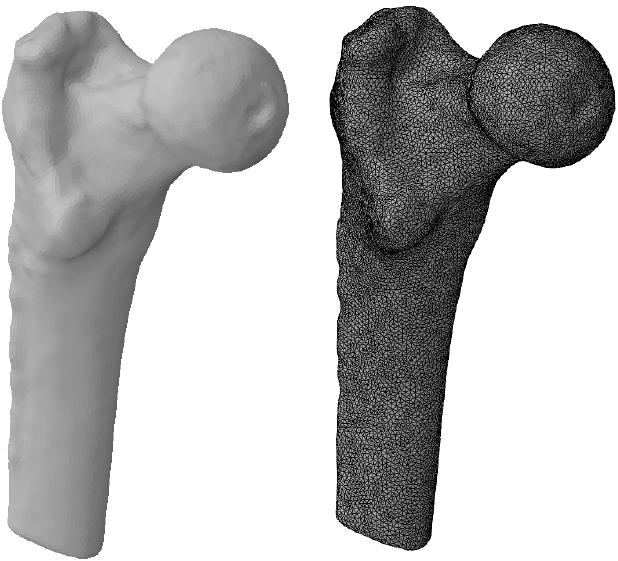
Figure 2. FE model of femur for test problem to evaluate elastic properties.